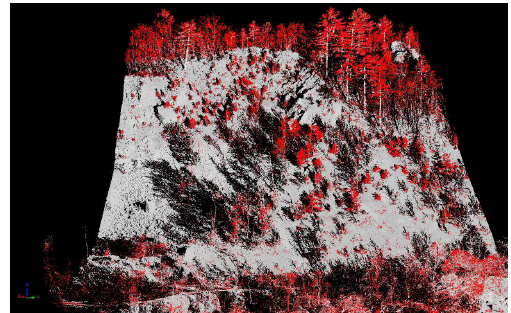
Figure 5: Example of vegetation filtering based on the calibrated reflectance.